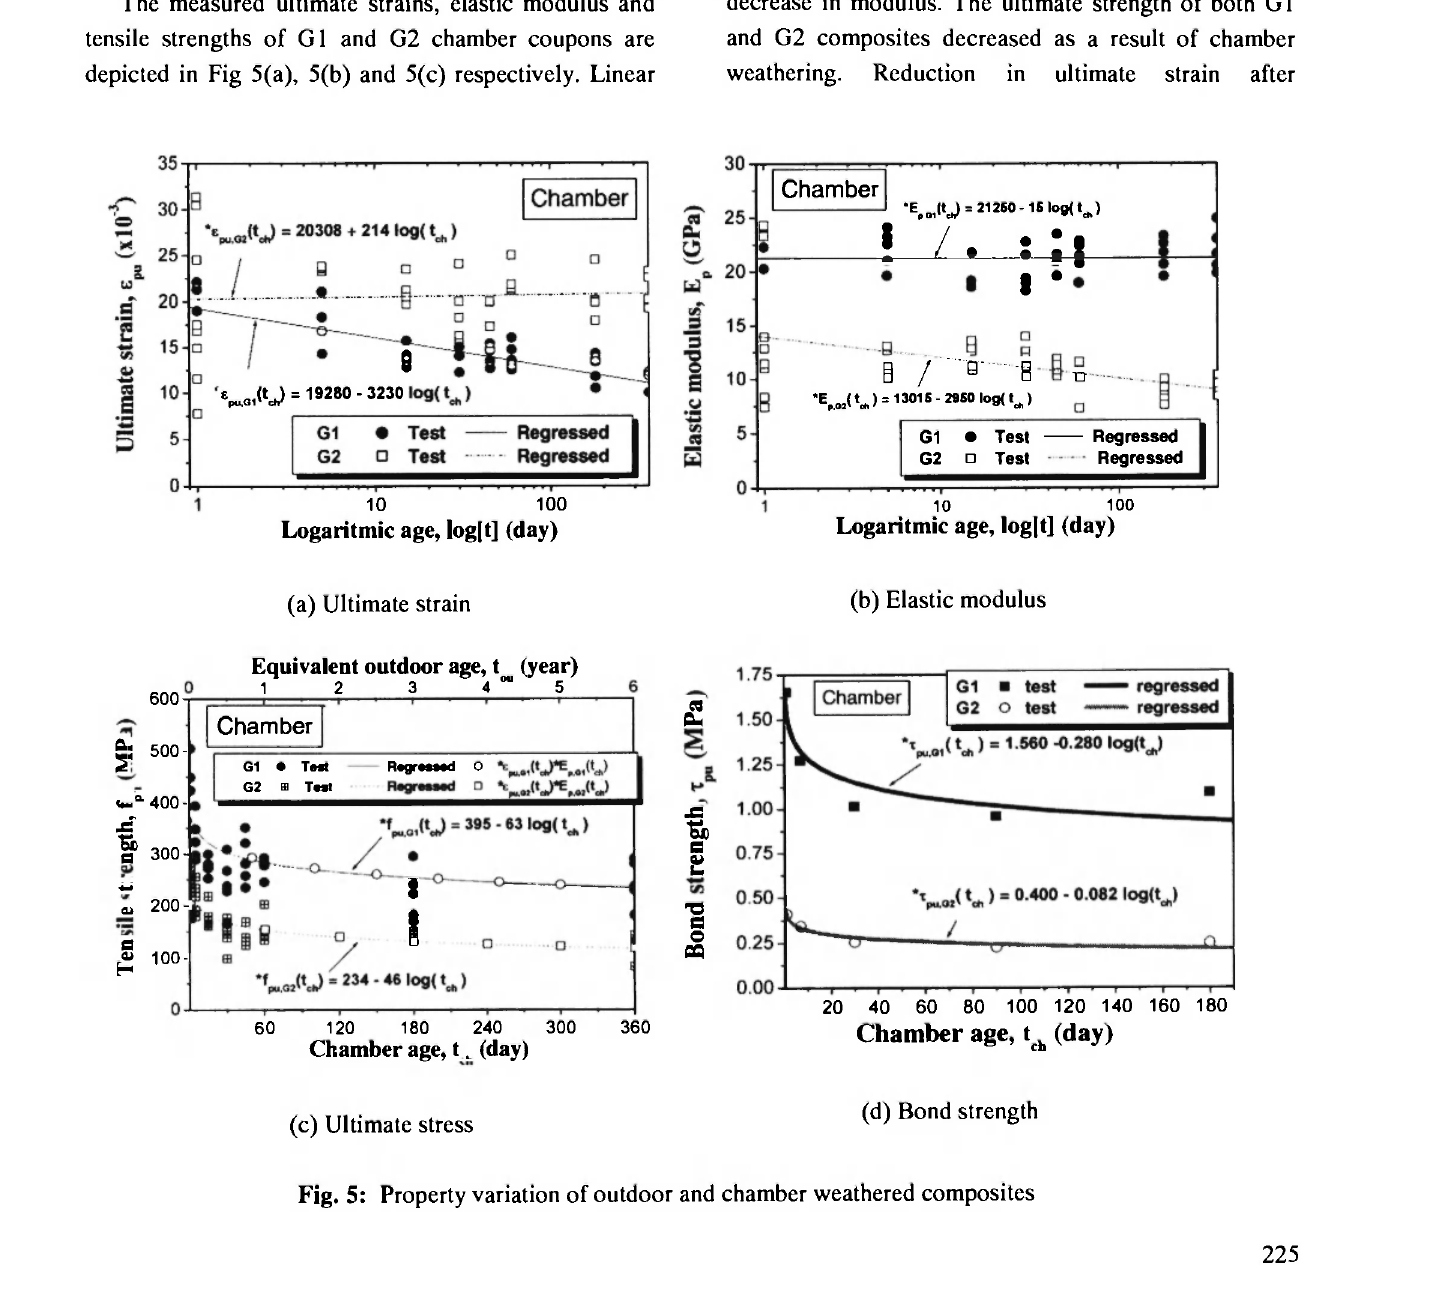
Fig. 5: Property variation of outdoor and chamber weathered